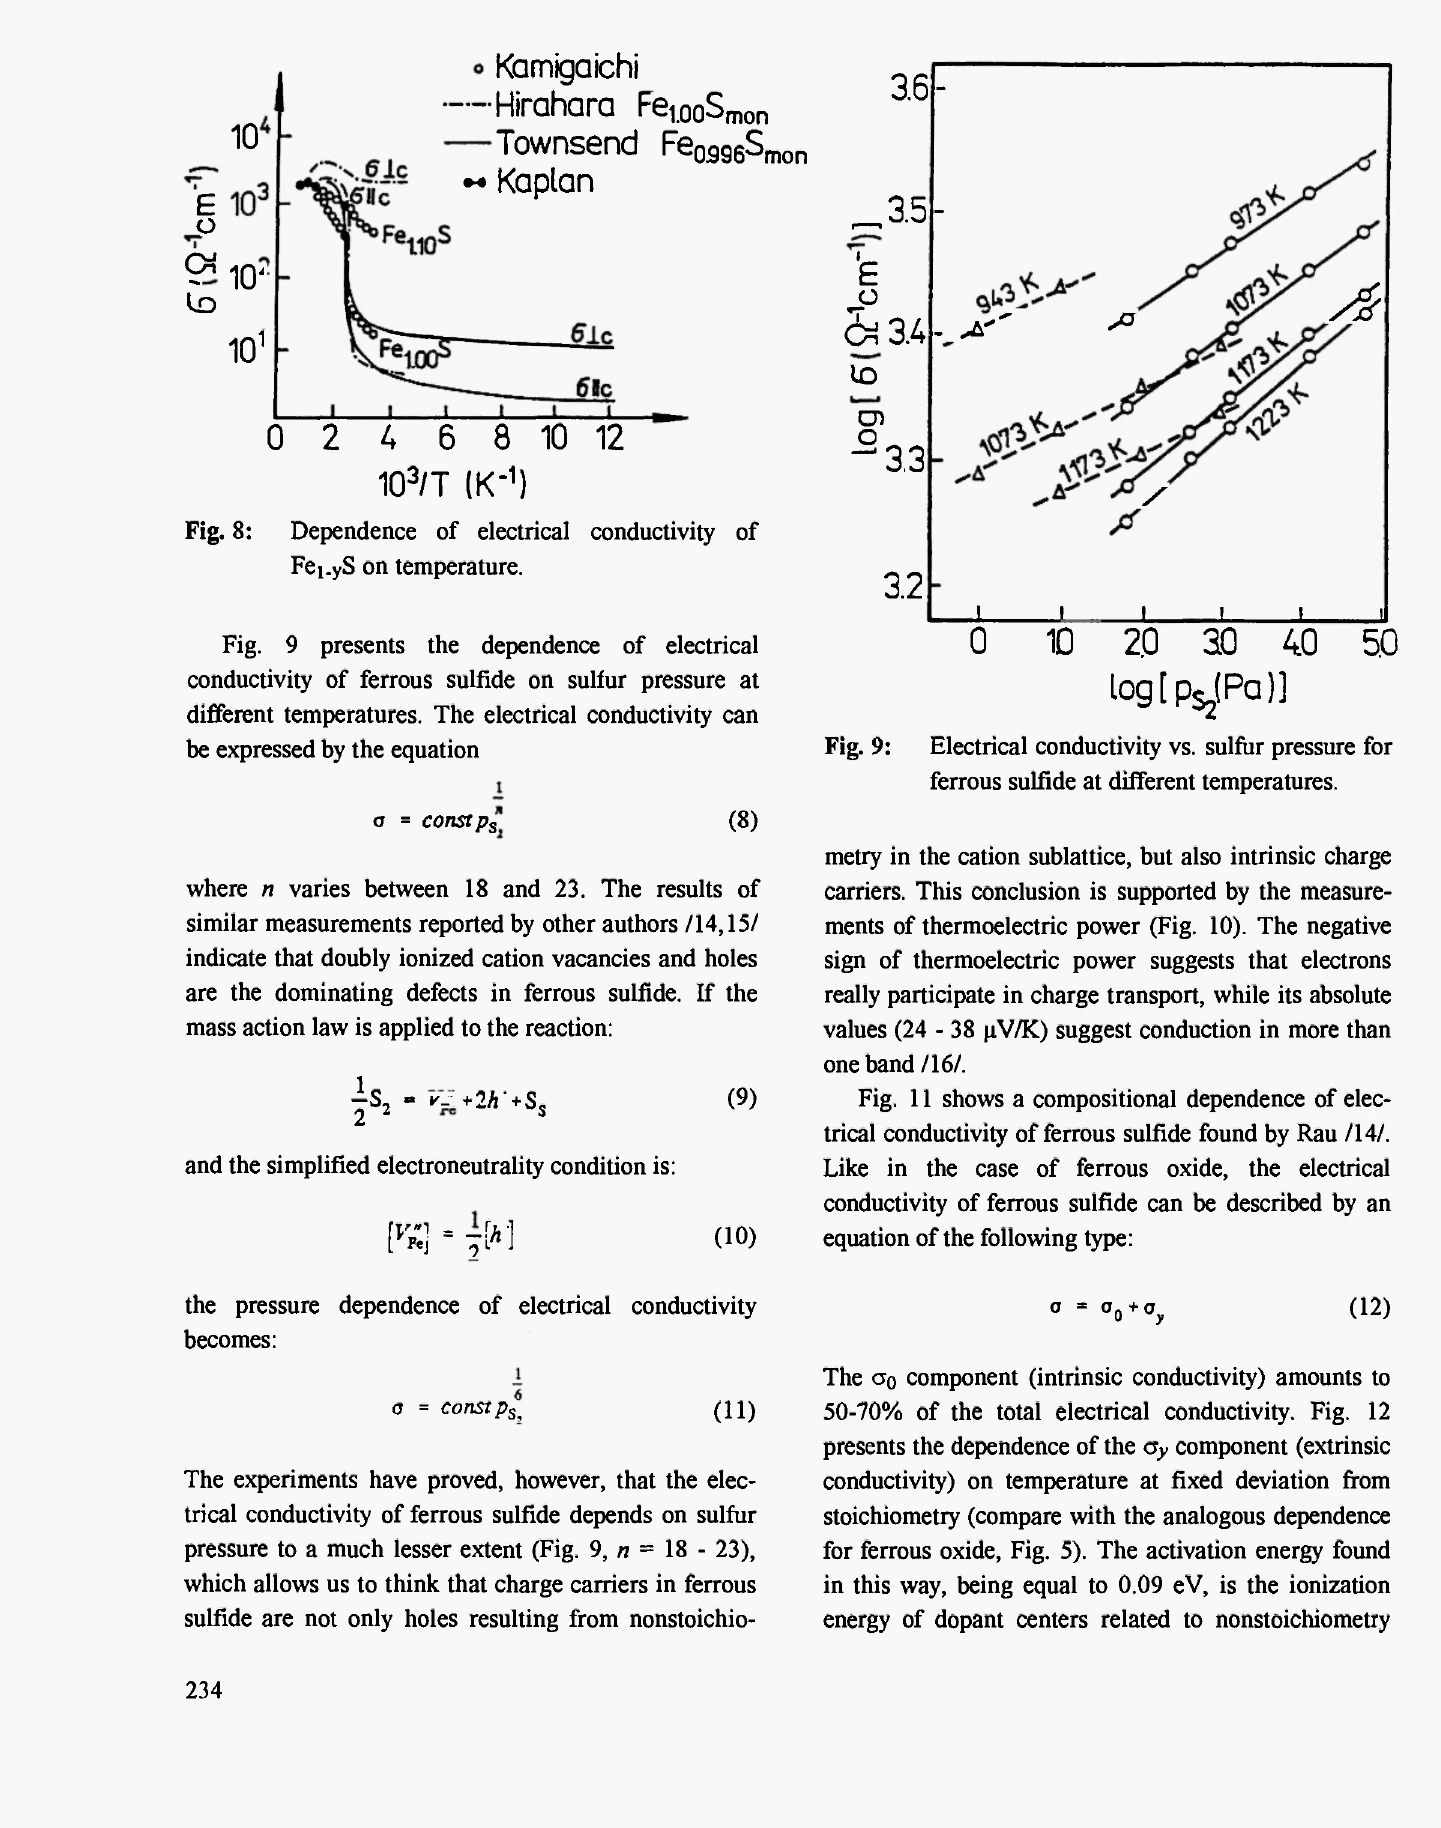
Fig. 8: Dependence of electrical conductivity of Fei.yS on temperature.